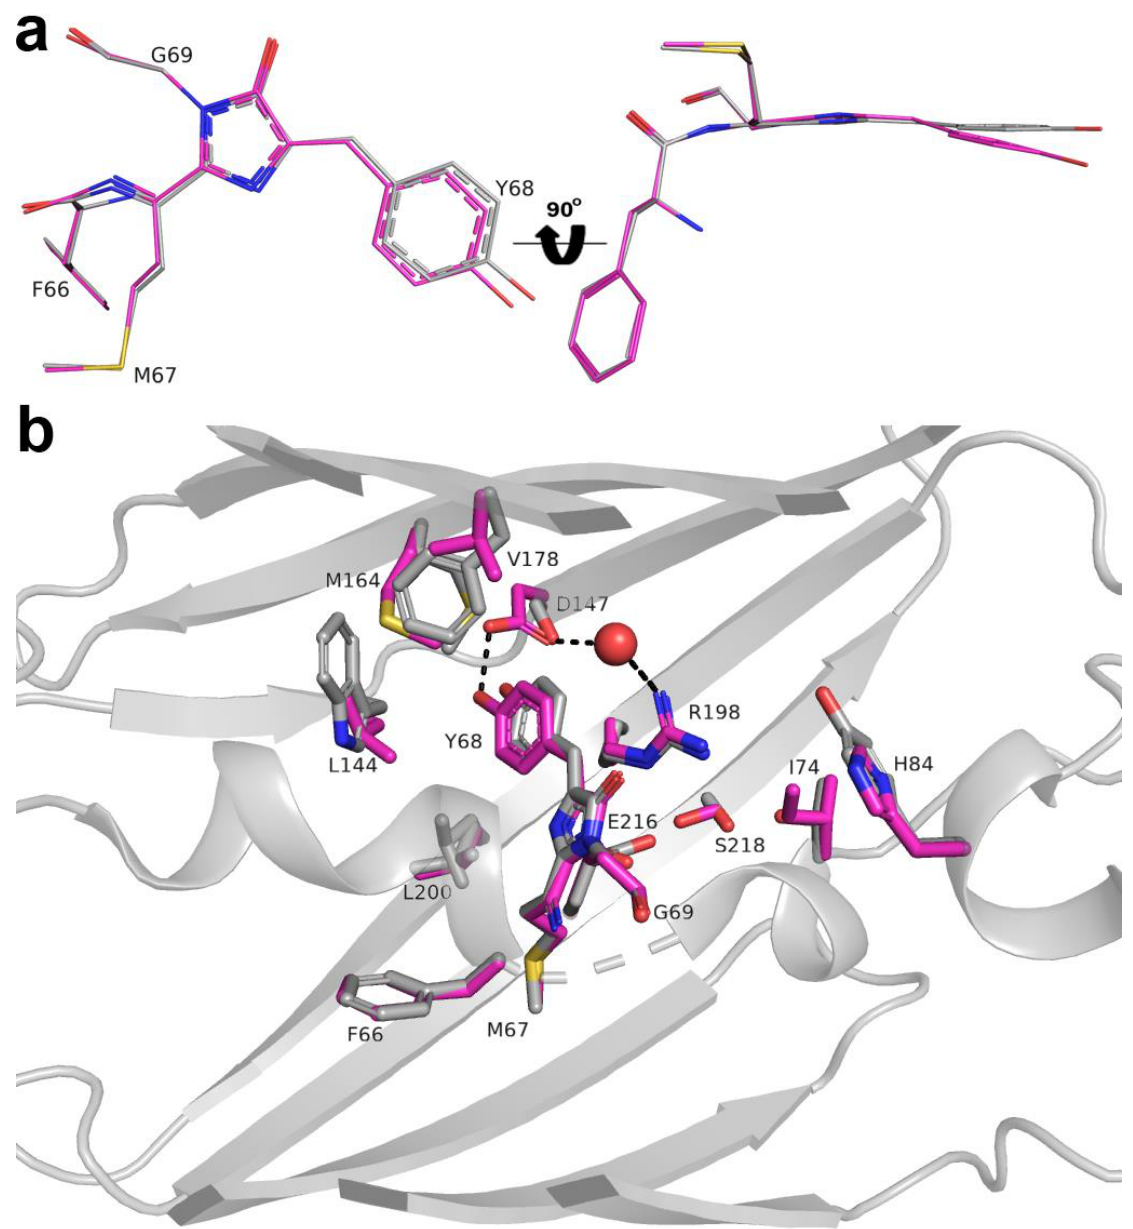
Figure 7. Structural comparison of the chromophores ( a ) and their immediate environments ( b ) for the LSSmScarlet and mScarlet (PDB: 5LK4) proteins. Water molecule (red sphere) provides hydrogen bonding (dashed lines) between D147 and R198 residues of the LSSmScarlet. D147 of LSSmScarlet makes a direct hydrogen bond (dashed line) with Y68 residue. Residues’ enumeration is shown for LSSmScarlet protein. In panel ( a ), the orientation of the chromophore on the right is rotated 90° around the horizontal axis with respect to that on the left.